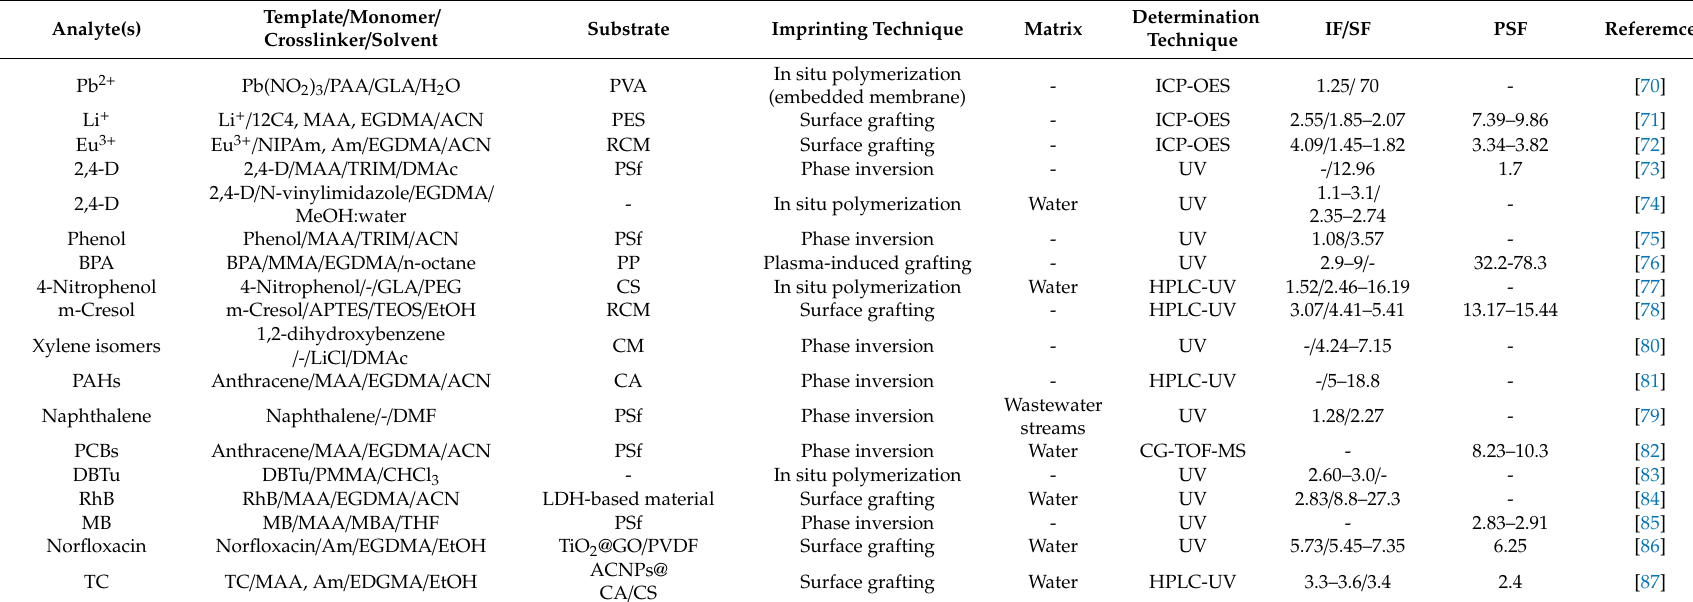
Table 3. Recent applications of MIMs in separation processes in environmental